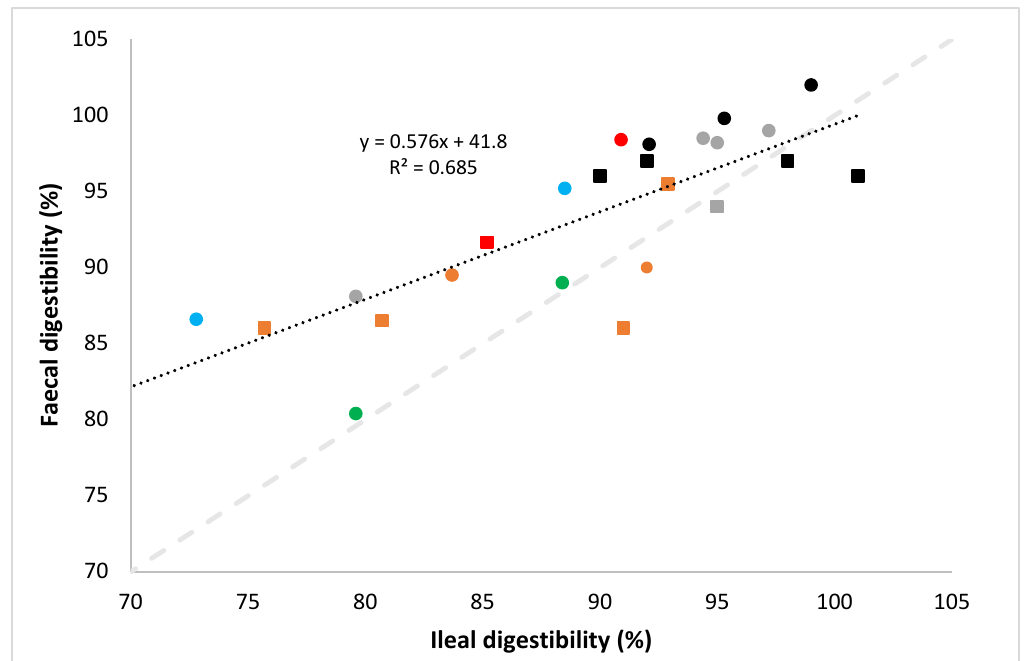
Figure 5. Relation between faecal digestibility and ileal digestibility protein from milk and milk protein concentrates and isolates ( , ), roasted nuts ( , ), cooked cereals ( ), raw cereals ( , ), legume and cereal protein isolates and concentrates ( , ) and cooked legumes ( ) tested in pigs